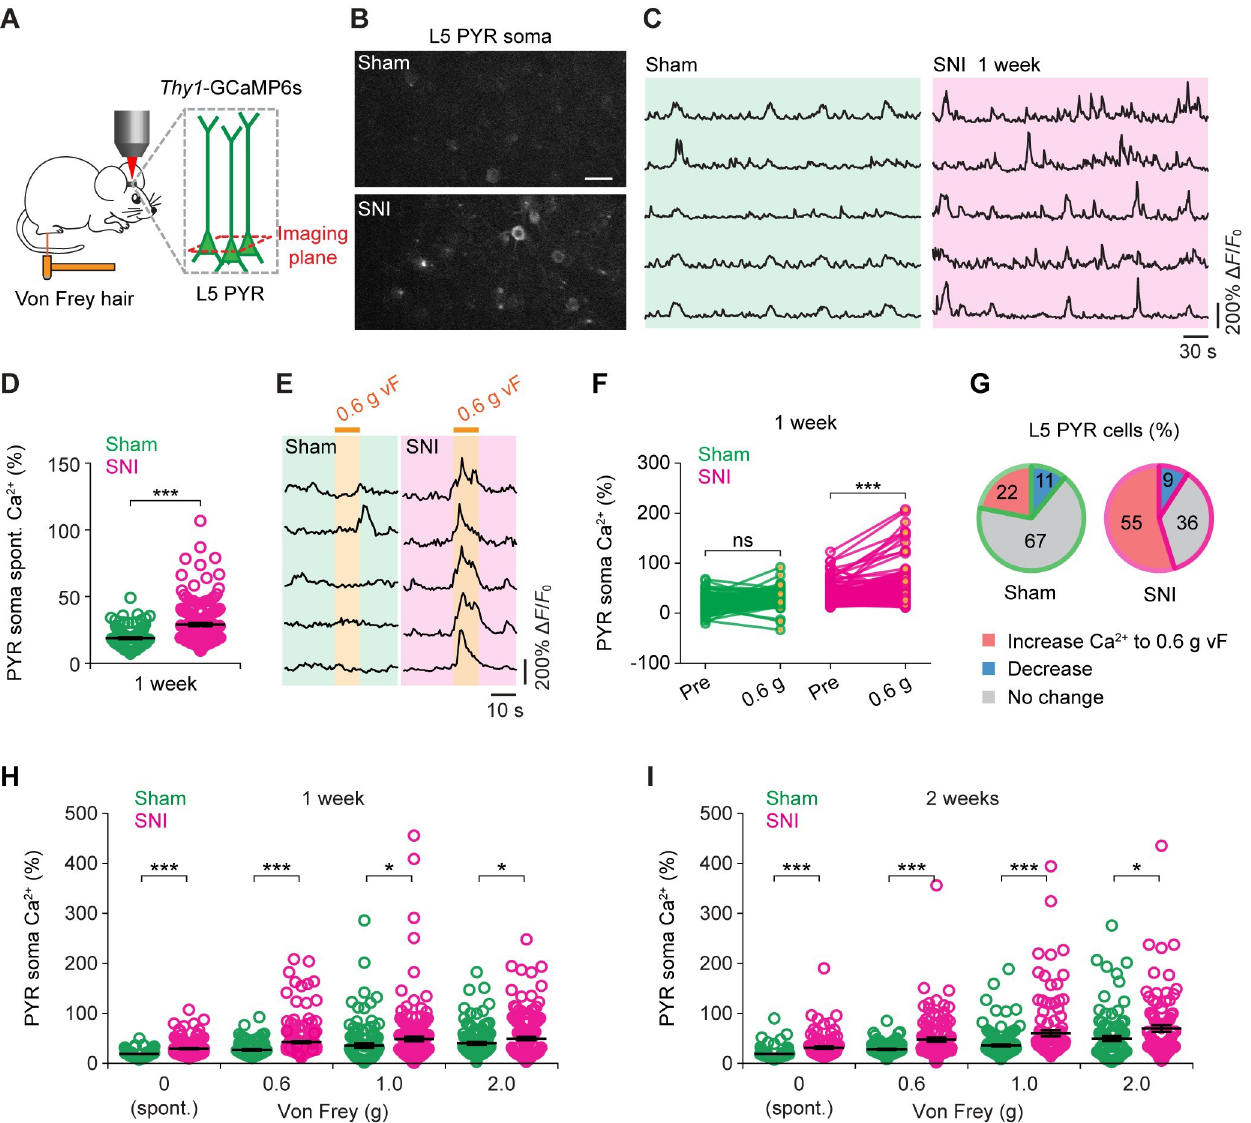
Fig 5. Enhanced sensory-evoked pyramidal neuronal activity in the S1 after peripheral nerve injury. ( A ) Cartoon depicting two-photon Ca 2+ imaging in awake, head-restrained mice expressing GCaMP6s in L5 PYR neurons. ( B ) Representative two-photon images of L5 somas in the S1 of sham and SNI mice 1 week after surgery. Scale bar, 20 μ m. ( C ) Representative fluorescence traces of L5 somas in SNI and sham mice 1 week after surgery. ( D ) Spontaneous Ca 2+ activity of L5 somas over 2.5 min 1 week after surgery (sham: 18.26 ± 0.73%, n = 115 cells from 5 mice; SNI: 28.57 ± 1.18%, n = 179 cells from 7 mice; t 292 = 6.501, P < 0.001). ( E ) Representative fluorescence traces of L5 somas in SNI and sham mice in response to mechanical stimulation applied by a 0.6-g vF hair. ( F ) Averaged Ca 2+ activity over 10 s before or during 0.6-g vF stimulation (sham: 20.80 ± 1.52%, 24.57 ± 1.47%, P = 0.123; SNI: 27.55 ± 1.27%, 41.67 ± 2.17%, P < 0.001). ( G ) Percentages of L5 somas showing increased Ca 2+ responses to 0.6-g stimuli in sham ( n = 115 cells) and SNI ( n = 179 cells) mice ( P < 0.01, chi- squared test). Ca 2+ activity was analyzed over 10 s. ( H ) vF stimulation–evoked somatic Ca 2+ in L5 neurons 1 week after surgery (sham: n = 5 mice; SNI: n = 7 mice; 0 g: t 292 = 6.501, P < 0.001; 0.6 g: t 329 = 4.963, P < 0.001; 1.0 g: t 265 = 1.981, P < 0.05; 2.0 g: t 276 = 2.028, P < 0.05). ( I ) vF stimulation–evoked somatic Ca 2+ in L5 neurons 2 weeks after surgery (sham: n = 5 mice; SNI: n = 5 mice; 0 g: t 211 = 4.920, P < 0.001; 0.6 g: t 238 = 4.983, P < 0.001; 1.0 g: t 245 = 4.124, P < 0.001; 2.0 g: t 190 = 2.421, P < 0.05). Throughout, individual circles represent data from a single cell. Data are presented as mean ± SEM. � P < 0.05, �� P < 0.01, ��� P < 0.001; by unpaired t test ( D, H, I ), paired t test ( F ). ( B, C, E ) Representative images and traces from experiments carried out on at least 5 animals per group. The data underlying this figure can be found in S1 Data. L5, layer 5; PYR, pyramidal; SNI, spared sciatic nerve injury; S1, primary somatosensory cortex; vF, von Frey.